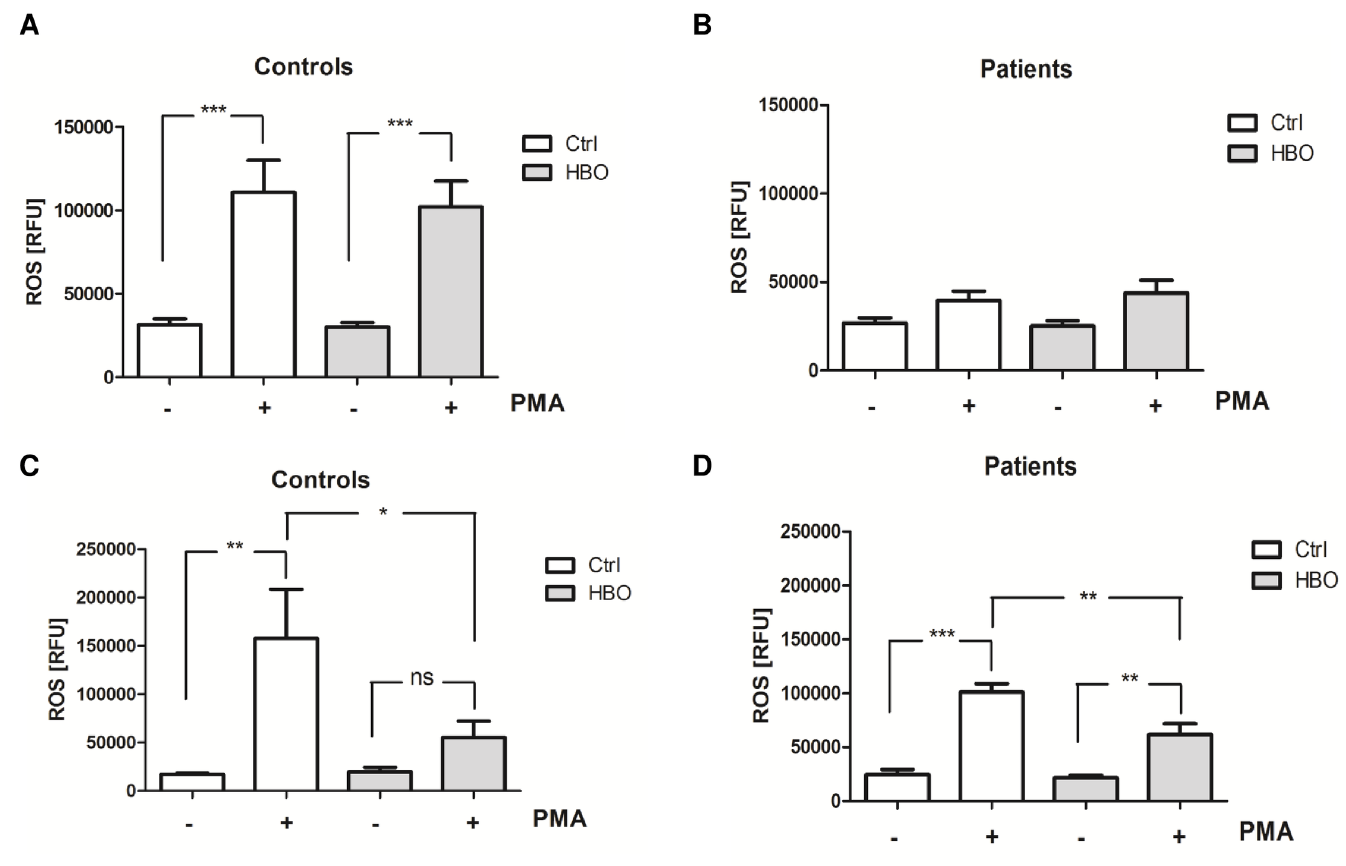
Fig 1. HBO impairs ROS production in control and inflammatory neutrophils. Freshly isolated neutrophils from healthy volunteers (Controls) (A, C; n = 6 – 11) and polytraumatized patients (Patients) (B, D; days 1 – 2 after trauma; n = 5 – 9) were exposed to HBO (HBO; 2.0 atm) for 120 min. Control cells (Ctrl) were incubated under normobaric, normoxic conditions for the same time. Cells were further stimulated with PMA (10 nM) for 10 min (A, B) and 3 hours (C, D), respectively. Intracellular ROS production was quantified by DHR 123 staining and expressed as relative fluorescence units (RFU). * p < 0.05; ** p < 0.01; *** p < 0.001; ns = not significant